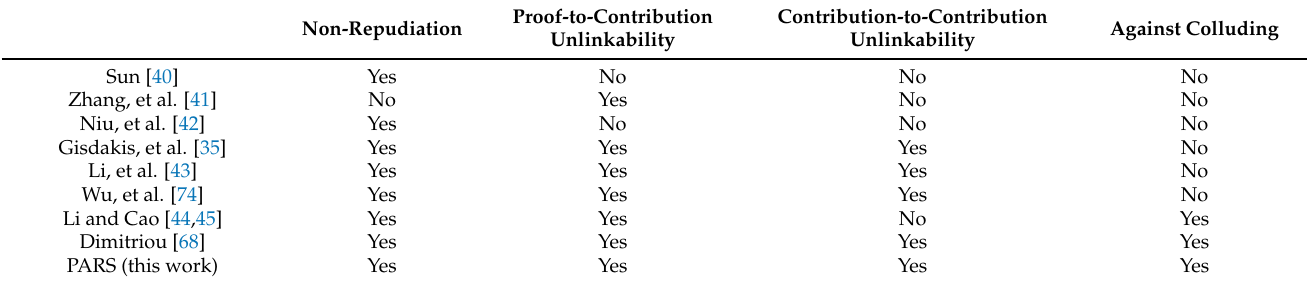
Table 3. Comparison of related works for privacy-preserving